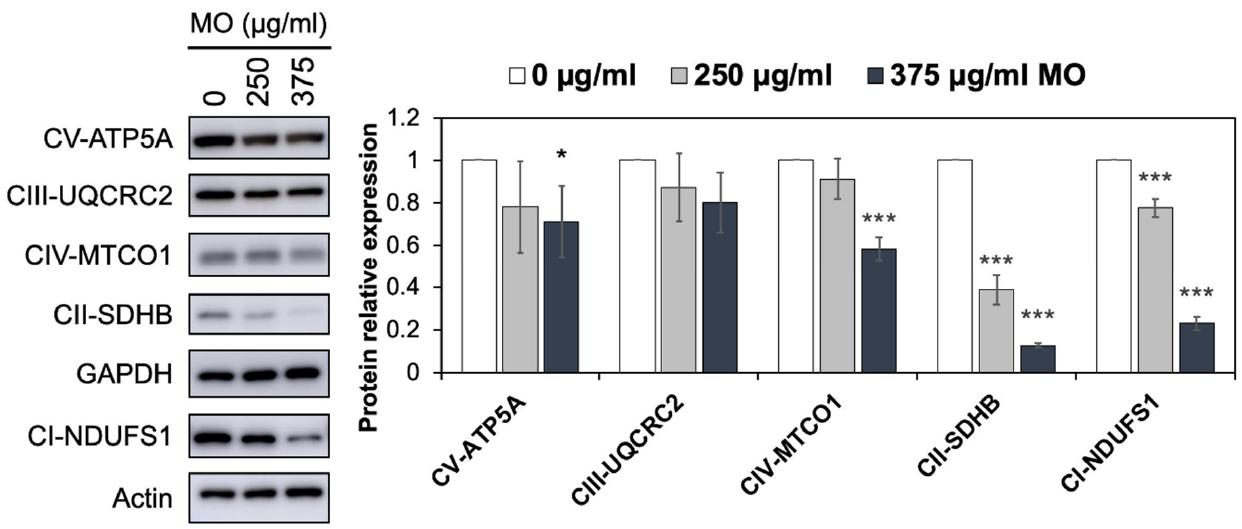
Figure 5. MO decreased the protein expression levels of OXPHOS complex I, II, and IV. HCT116 cells were treated with MO (0, 250, 375 μ g/mL) for 48 h. Protein expression levels of OXPHOS were analyzed by western blot and normalized to GAPDH or Actin expression. Bars represent the relative protein expression of complex I-V (CI-V). Relative values (mean ± SD, n = 3) were normalized to GAPDH or Actin expression. *** p < 0.001, * p < 0.05 versus the vehicle control (0 μ g/mL MO).